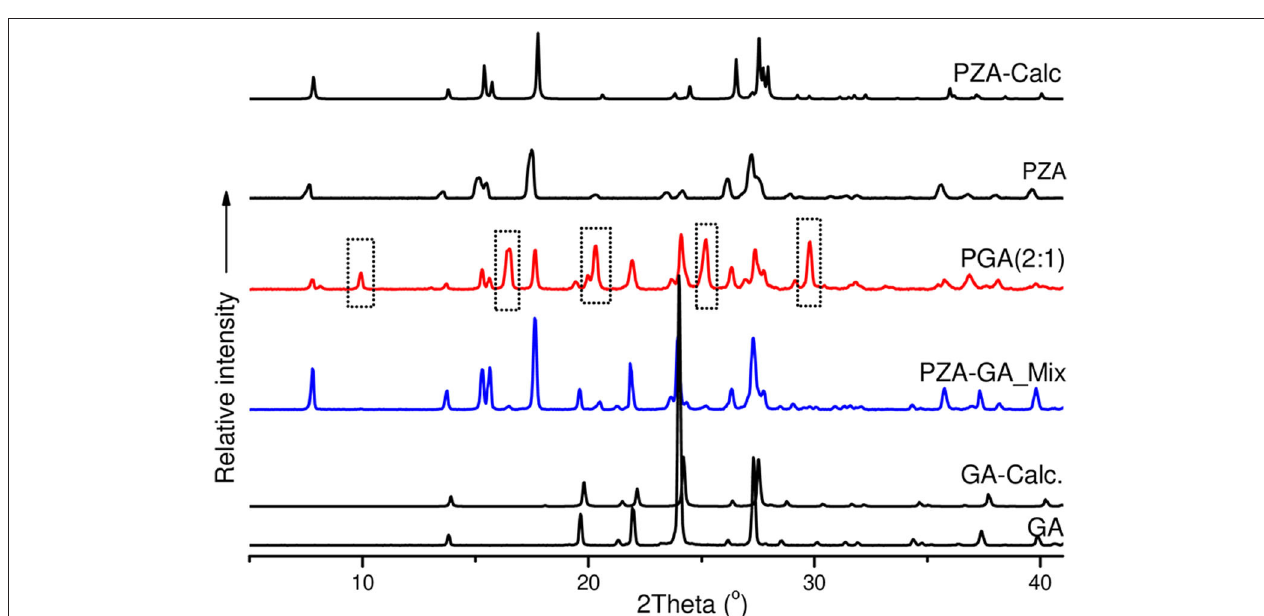
FIGURE 8 | PXRD patterns of pure and calculated pyrazinamide, pure and calculated pentanedioic acid, PZA-GA physical mixture and PGA (2:1) co-crystal.